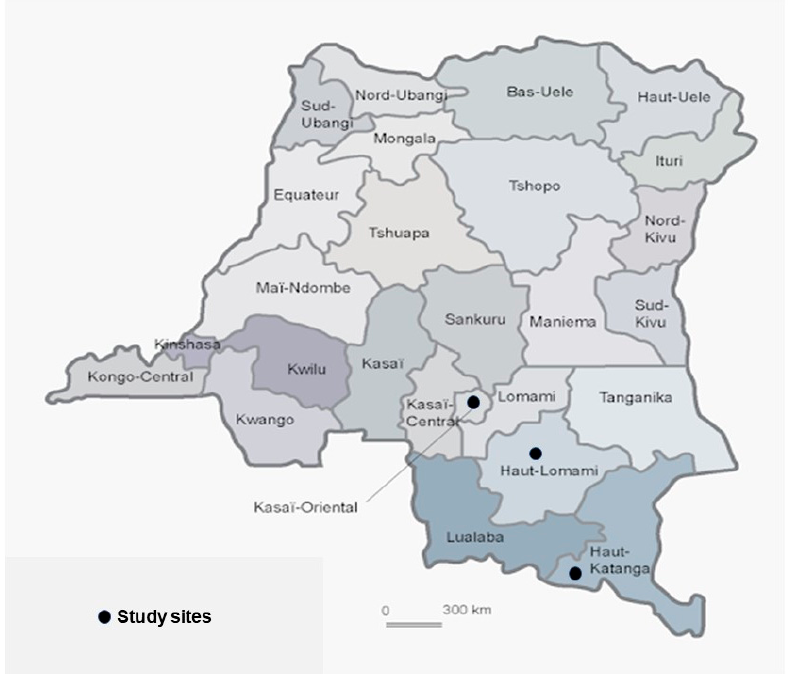
Figure 1. Map of Africa and the Democratic Republic of the Congo (source: Wikimedia).